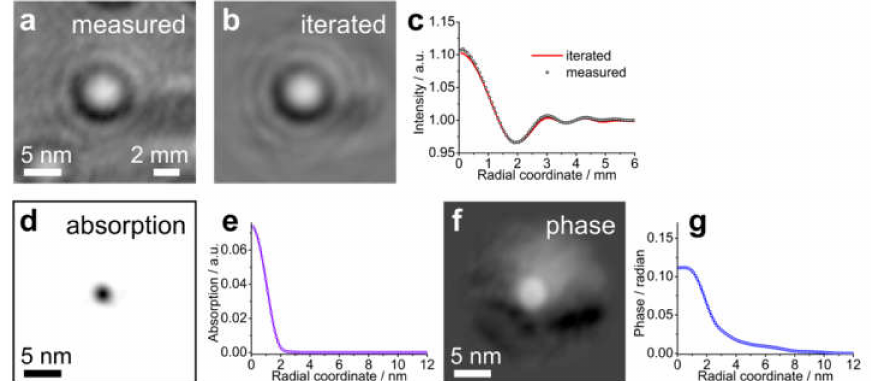
Figure 23. Iteratively reconstructed absorption and phase distribution of an individual charged impurity. ( a ) In-line hologram recorded with 30 eV electrons, exhibiting a bright spot. ( b ) Intensity distribution of the recovered wavefront obtained after 2000 iterations. ( c ) Angular-averaged radial profiles of the measured and iteratively recovered intensity distributions. ( d , f ) iteratively reconstructed absorption and phase distributions. ( e , g ) corresponding angular-averaged radial profiles. Reprinted from [74], with permission from